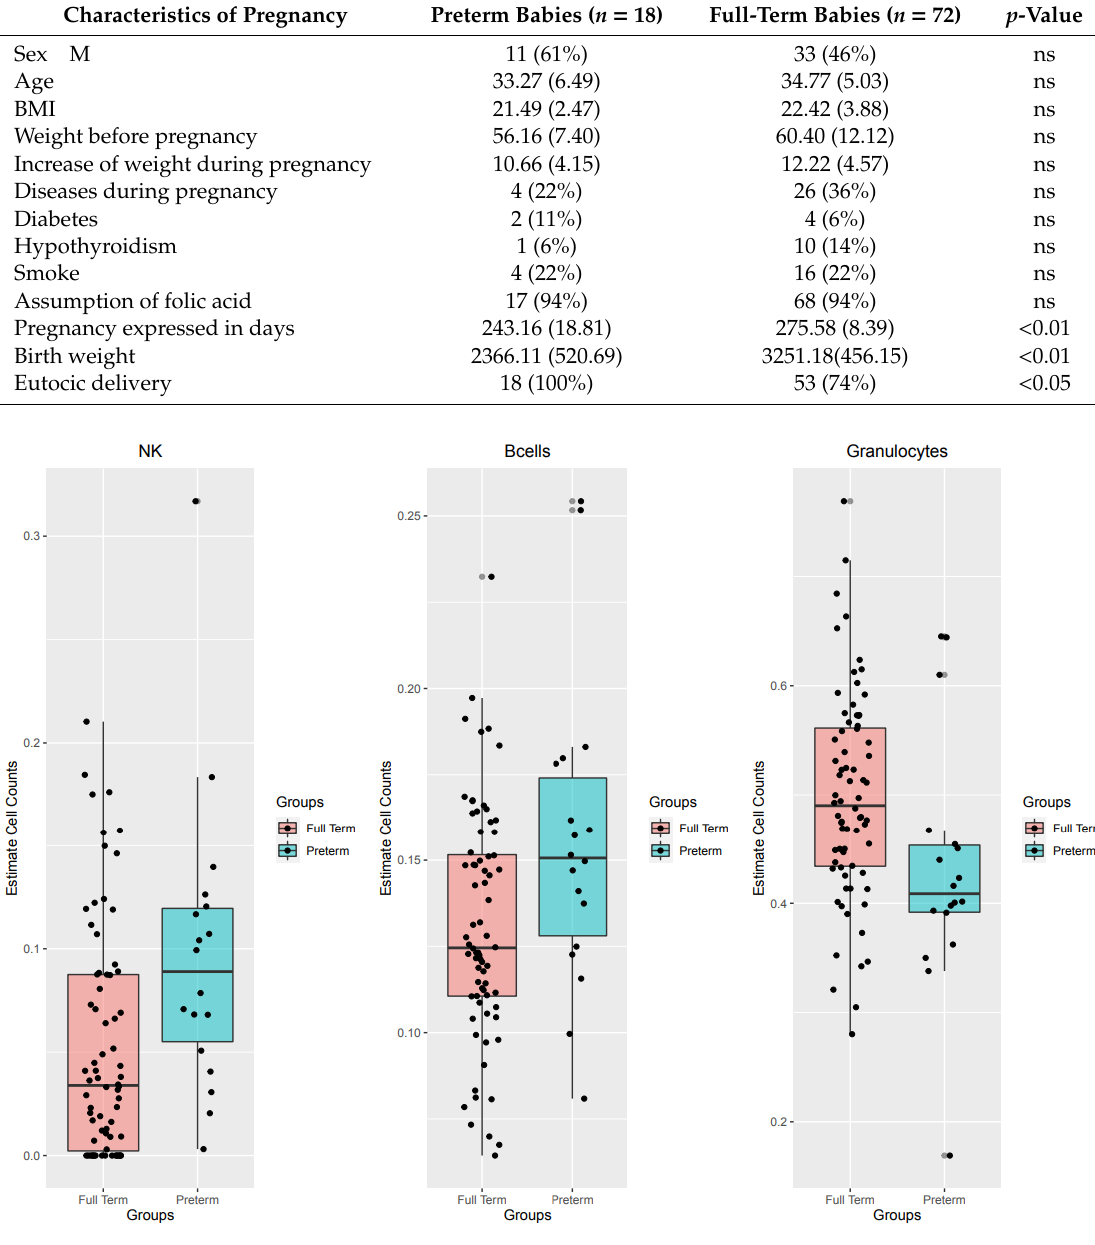
Table 1. Phenotypic characteristics of the 90 subjects recruited: 18 preterm and 72 full-term babies. Characteristics of Pregnancy